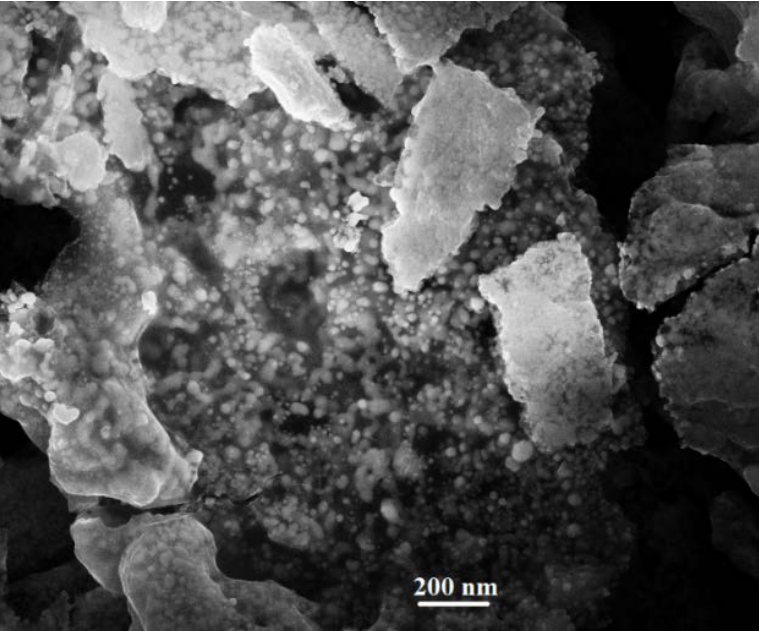
Figure 9. SEM image of a sample of the thermolysis product of silver maleate. The XRD analysis data (Figure 10) show that the thermolysis product contains me- tallic silver. The calculation of the size of the silver crystallites using the Debye-Scherrer formula gives the values 7.4, 8.6, 11.3, 27.5, and 43.8 nm.